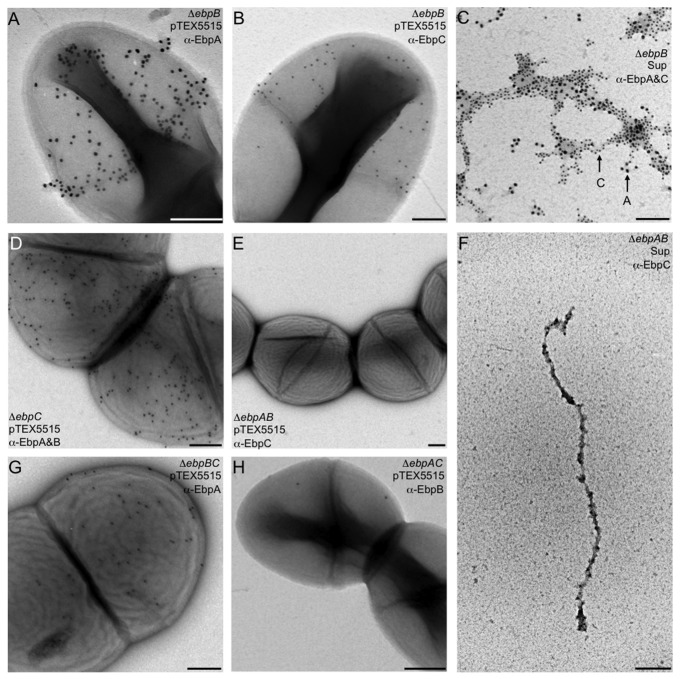
IEM analysis of pilus production by ebp deletion mutants of E. faecalis OG1RF.(A) ΔebpB (pTEX5515) stained with anti-EbpA (18 nm); (B) ΔebpB (pTEX5515) stained with anti-EbpC (12 nm); (C) culture supernatant of ΔebpB double stained with anti-EbpA (18nm) and anti-EbpC (12 nm); (D) ΔebpC (pTEX5515) stained with anti-EbpA (12 nm) and anti-EbpB (18nm); (E) ΔebpAB (pTEX5515) stained with anti-EbpC (12 nm); (F) culture supernatant of ΔebpAB stained with anti-EbpC (12 nm); (G) ΔebpBC (pTEX5515) stained with anti-EbpA (12 nm); (H) ΔebpAC (pTEX5515) stained with anti-EbpB (18 nm). All above strains were grown in TSBG to exponential phase. Scale bars 200 nm.